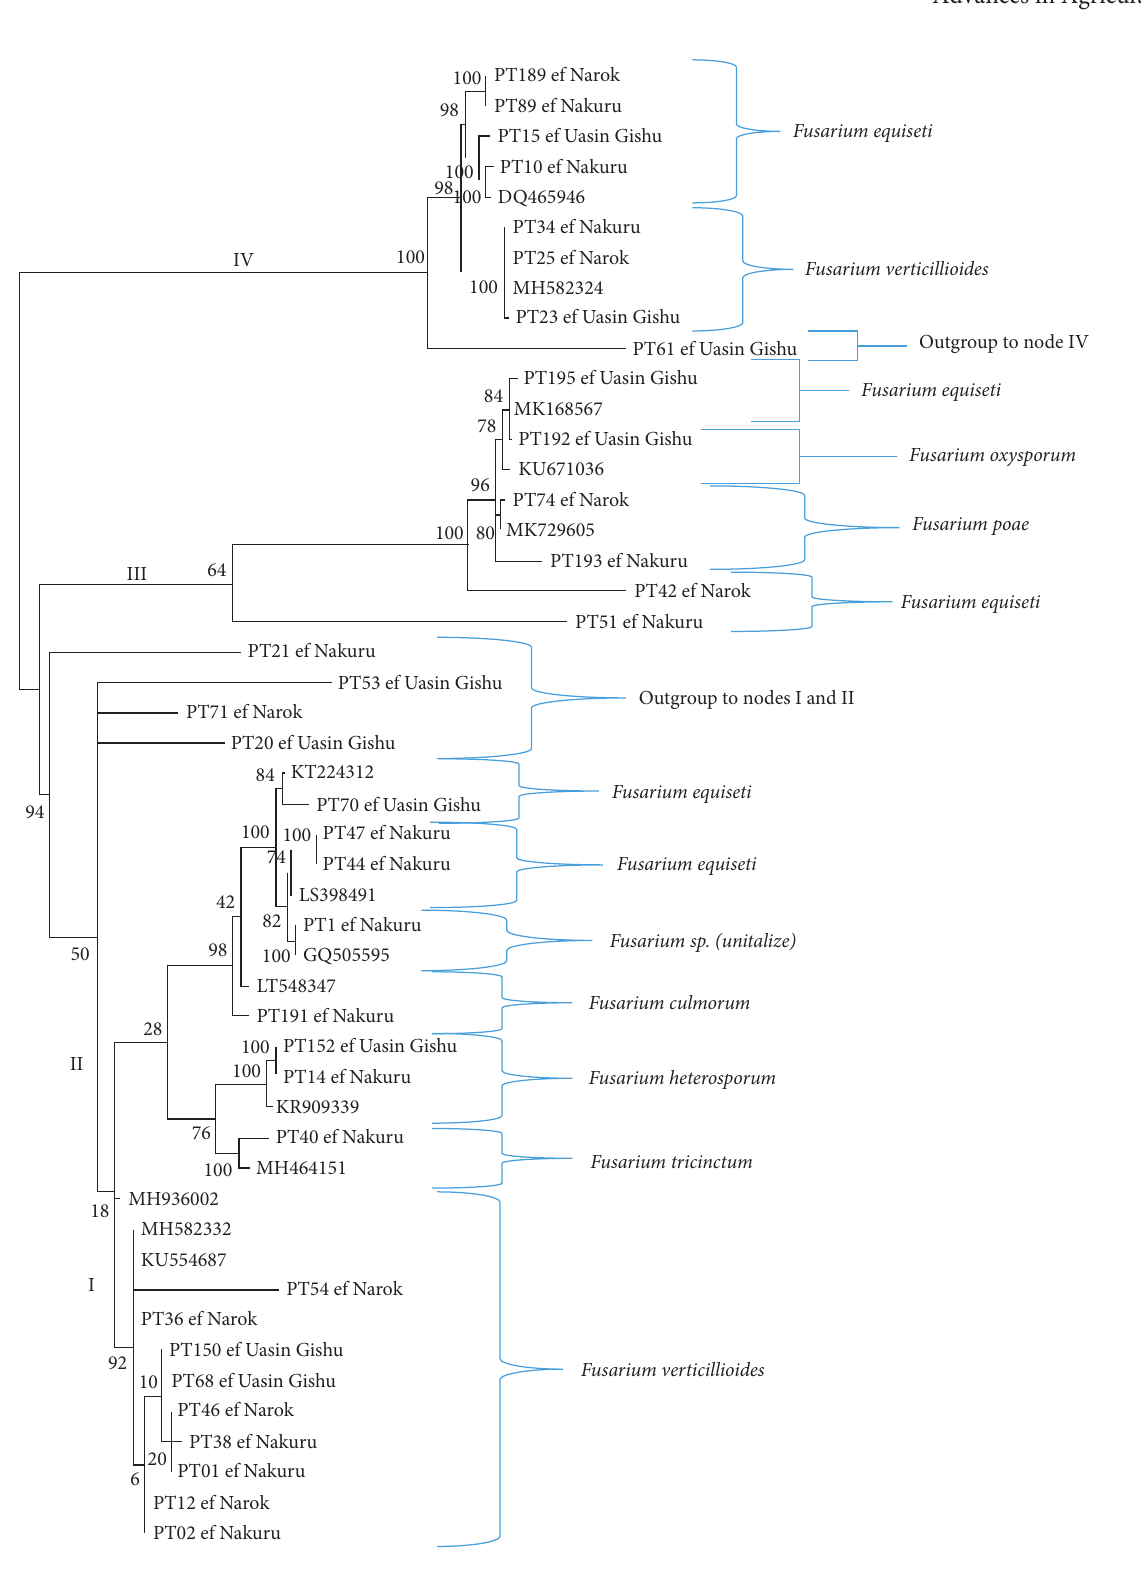
Figure 2: Phylogenetic tree of Fusarium spp. isolated from freshly harvested genotypes of wheat seeds in three Rift Valley regions, Kenya. The analysis was based on tef1- α gene sequences and by the maximum likelihood method with 1,000